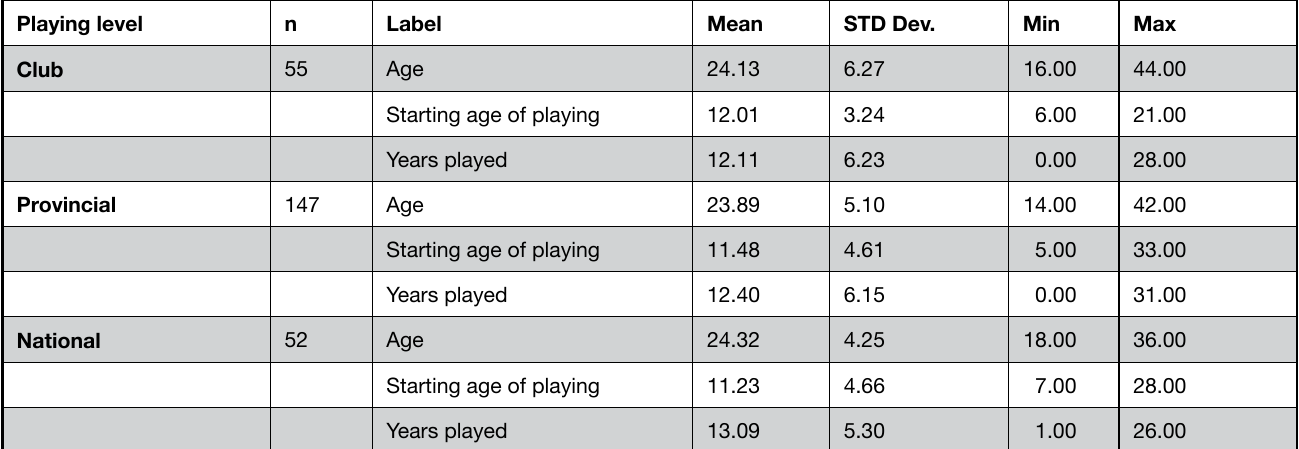
Table 1: Sample description by age (n=254) Playing level n